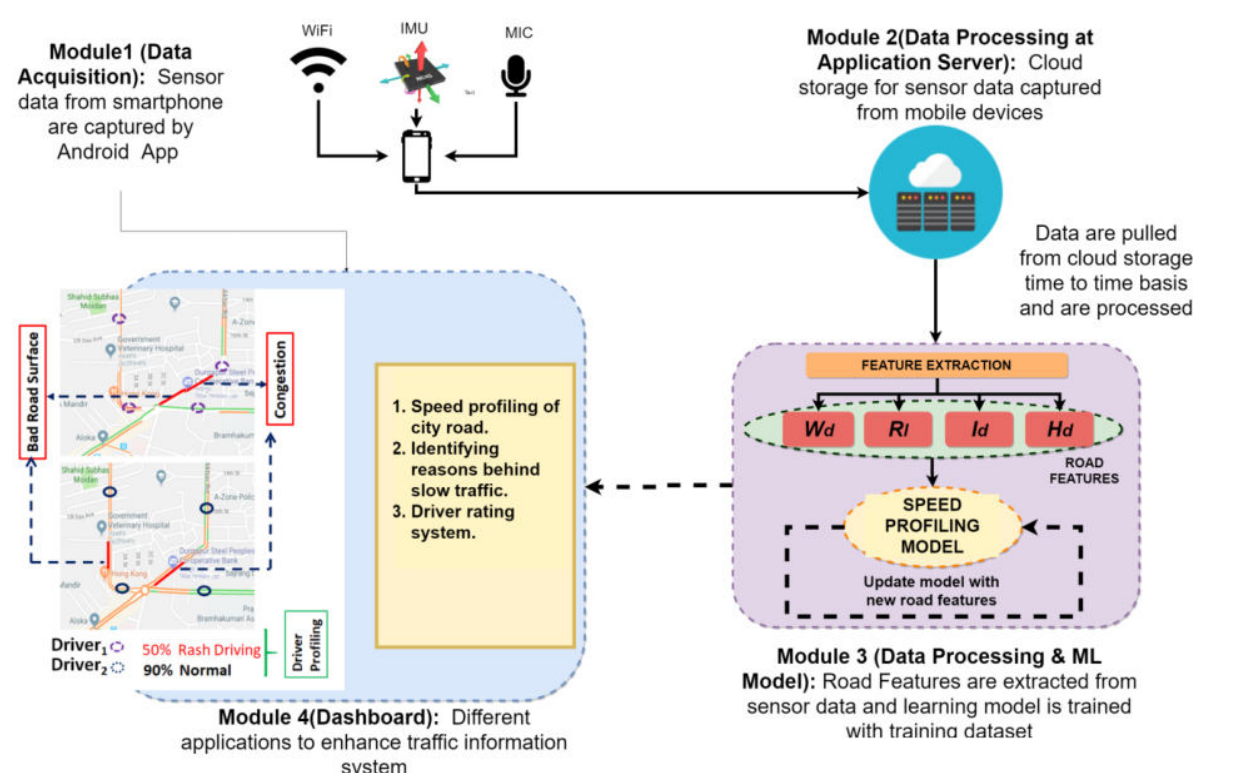
Figure 1. System architecture for Speed Profiling, For a road segment ( Seg i ), road features are: (a)Honk duration( H d ), (b)Road Surface Index ( R I ), (c)Intersection Density ( I d ) & WiFi Density ( W d